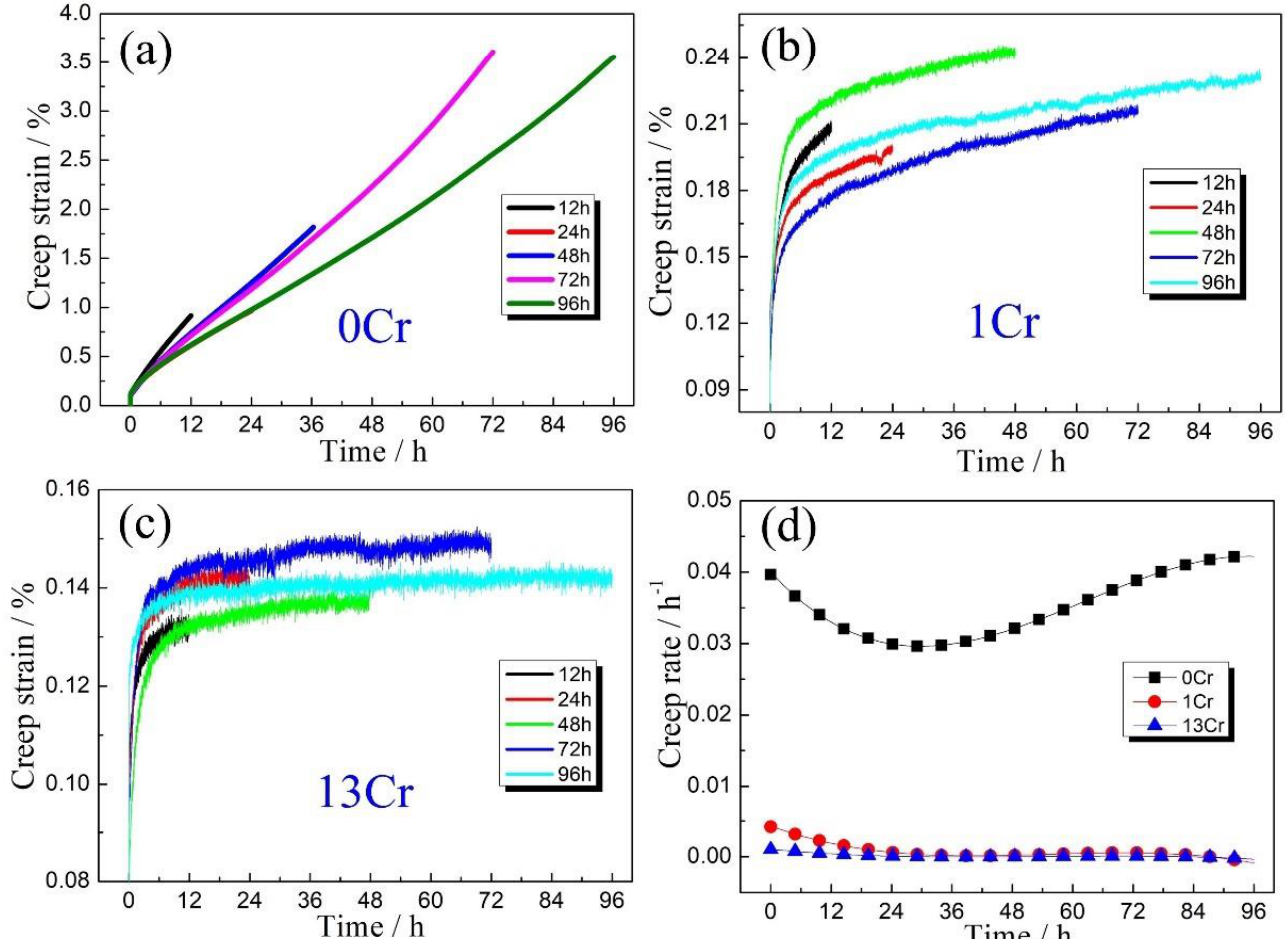
Figure 1. Typical creep curves of three types of samples subjected to various creep times: ( a ) 0Cr samples; ( b ) 1Cr samples and ( c ) 13Cr samples. ( d ) Corresponding variations of steady-state creep rate against creep time.